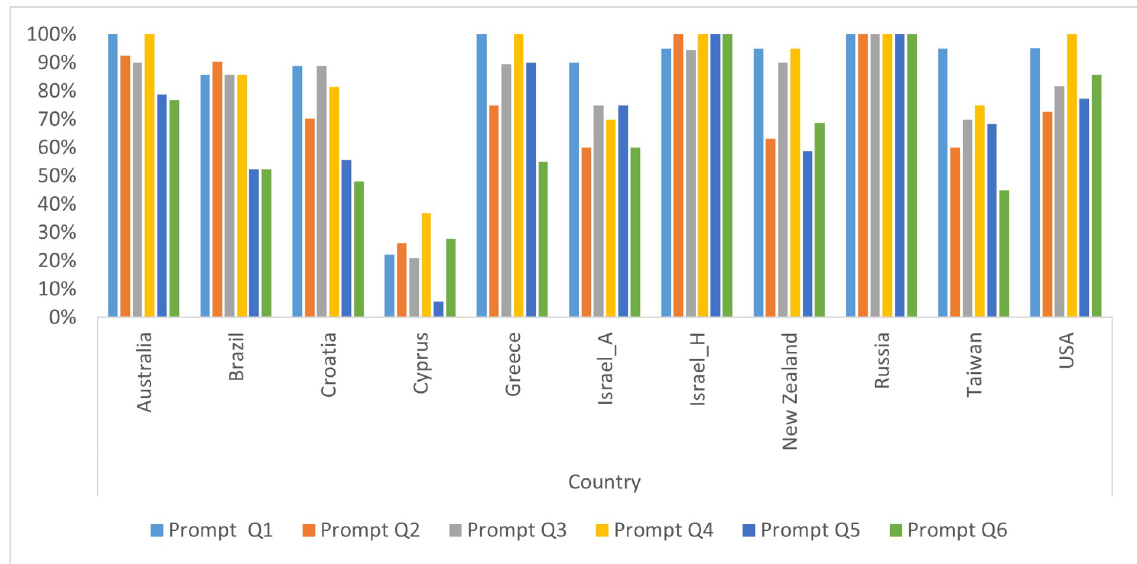
Fig 3. Percentage of responses elicited without a scripted follow-up prompt, by country/language.